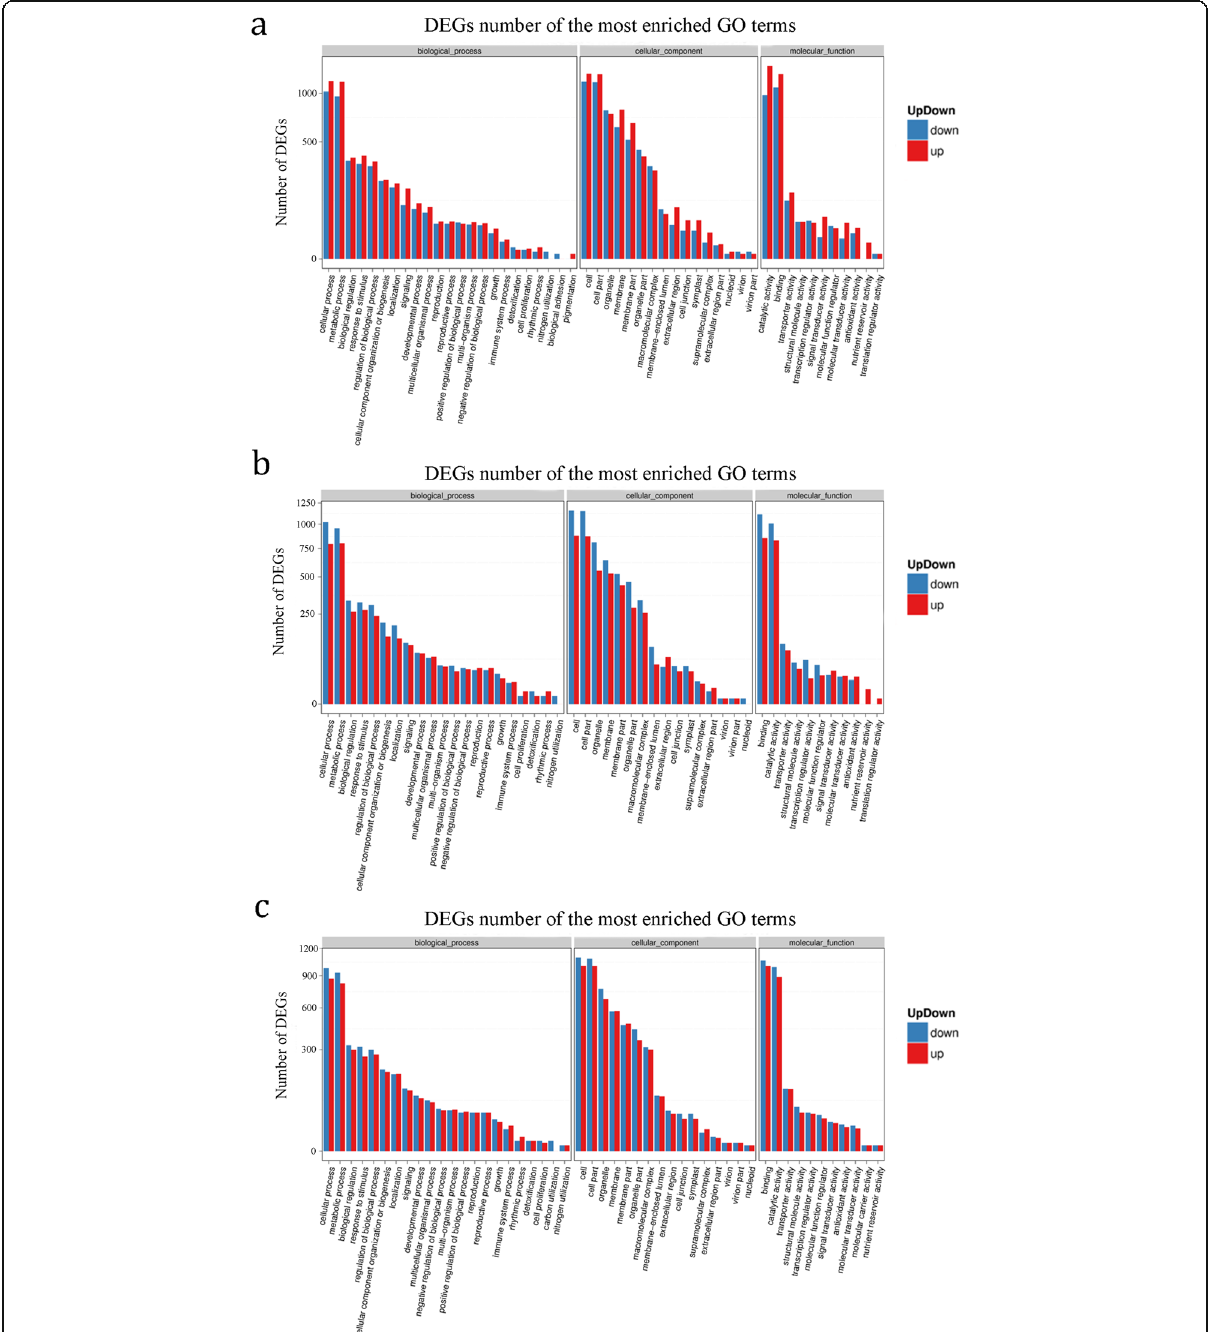
Fig. 6 GO enrichment of DEGs between BYDV-GAV-inoculated P. huashanica at different time after inoculation and mock-inoculated samples, respectively. Enriched GO terms between BYDV-GAV-inoculated P. huashanica at 3 dpi and mock (a) , 7 dpi and mock (b) , 14 dpi and mock (c) . The X-axis represents the functional category and the Y-axis represents the number of